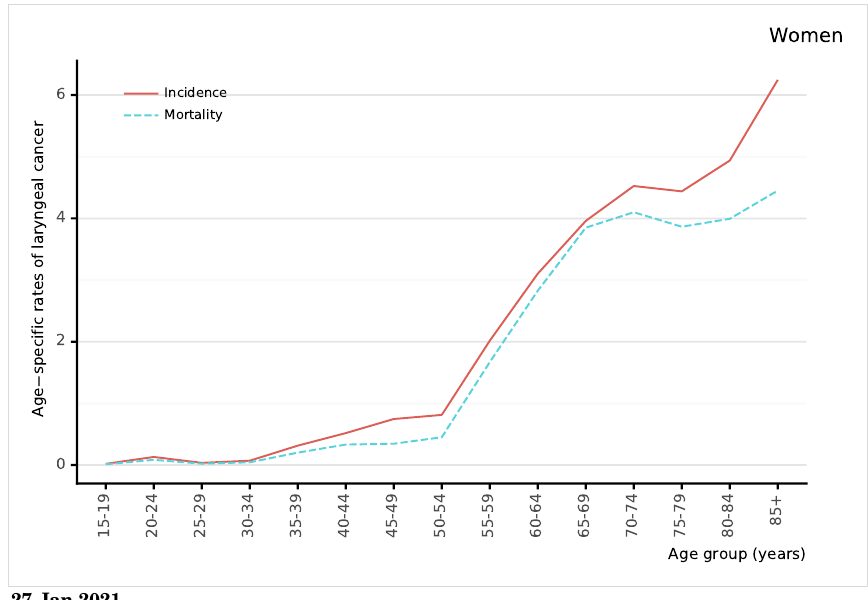
Figure 53: Comparison of age-specific laryngeal cancer incidence and mortality rates among women